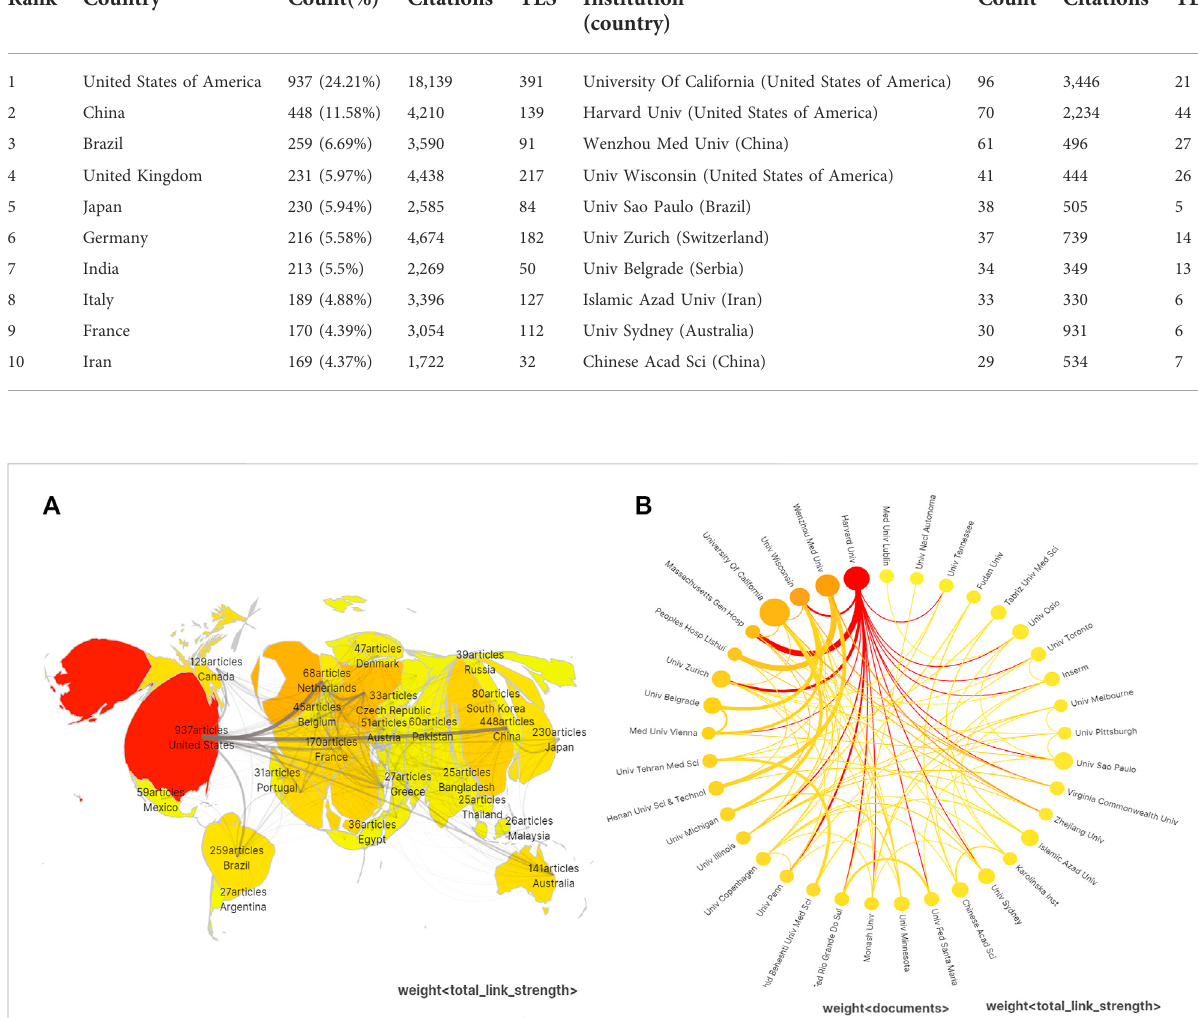
TABLE 1 Distribution of publications according to country/region and institution. Rank